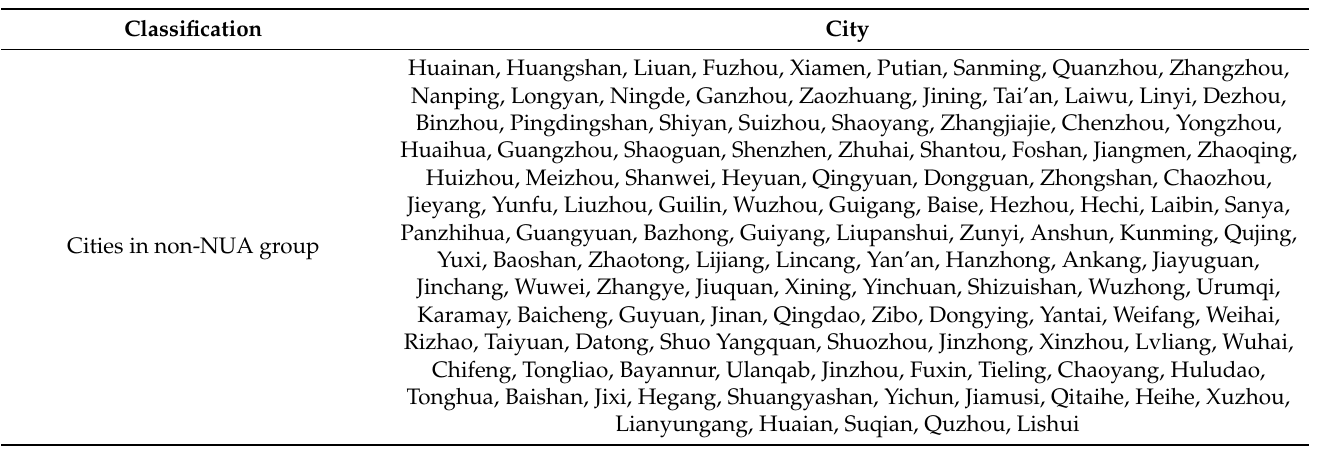
Table A2. The 125 cities in the non-NUA